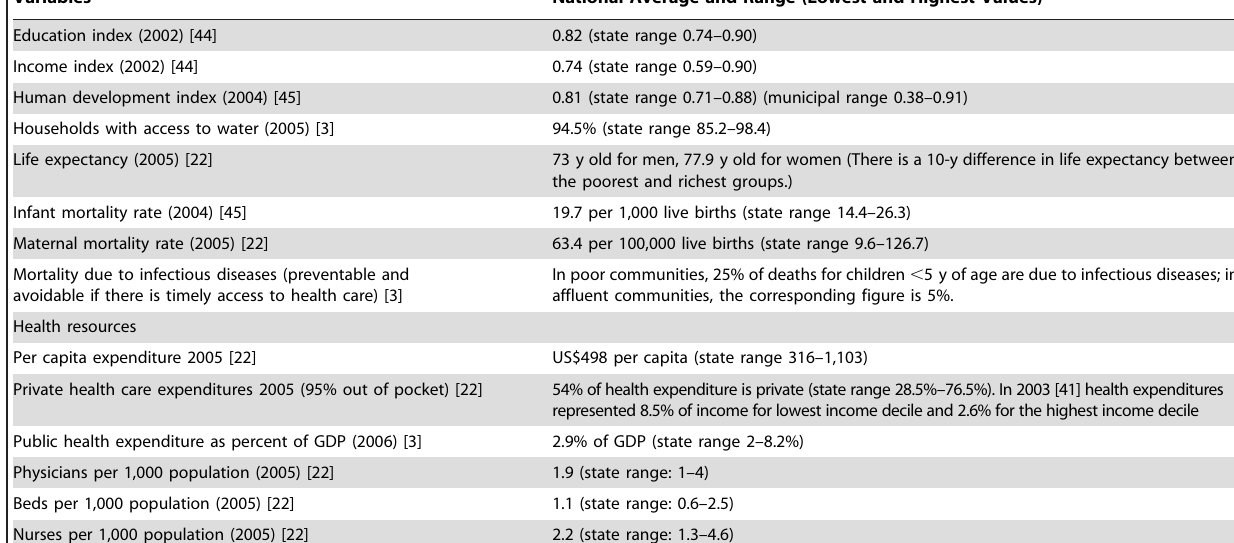
Variables National Average and Range (Lowest and Highest Values)